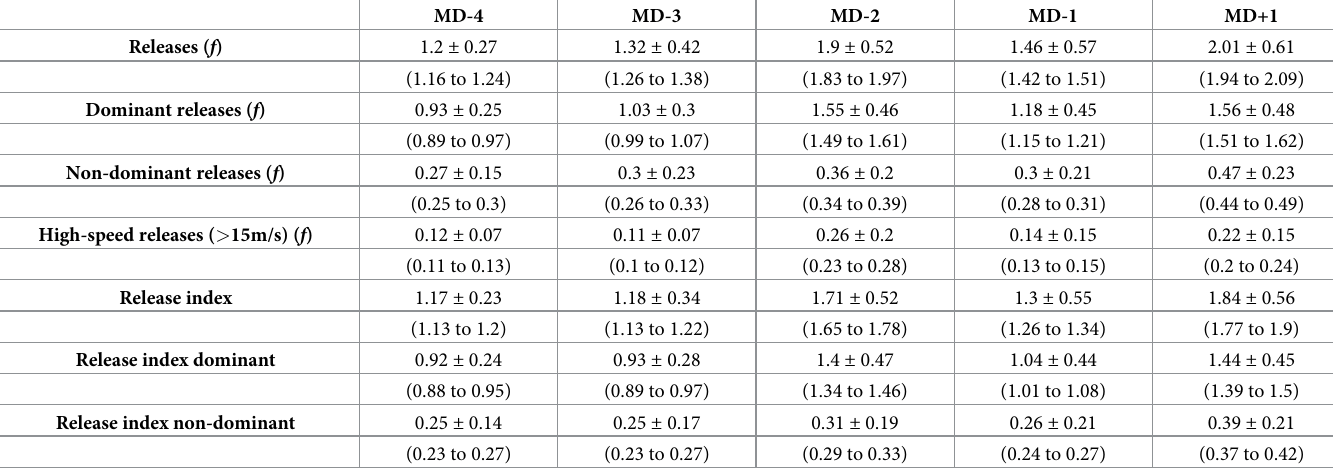
Table 2. Estimated marginal means ( ± SE) and 95% confidence interval values representative of the relative frequency of ball releases, dominant ball releases, non- dominate ball releases, high-speed ball releases, ball release index, ball release index dominant and ball release index non-dominant for professional soccer players according to match proximity (match day